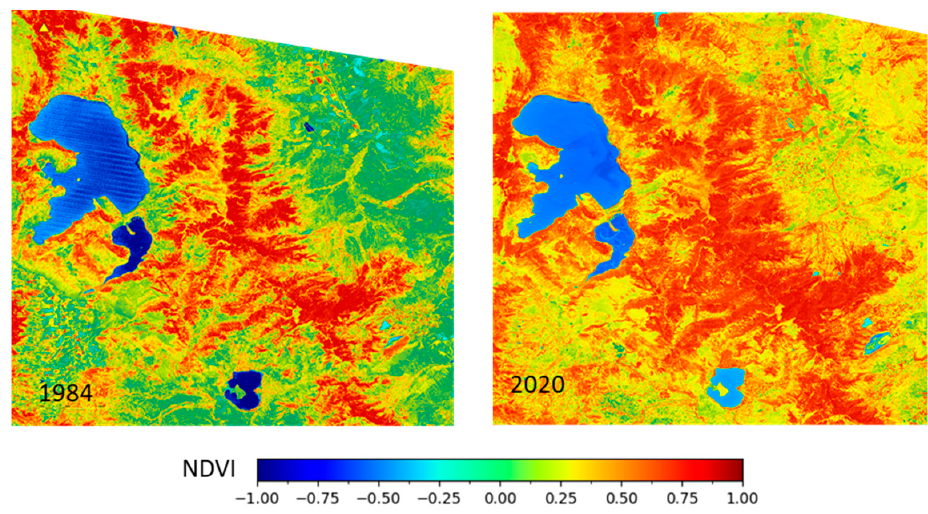
Figure 5. NDVI values in the region of Prespa Lake, Baba Mountain and the adjacent area.